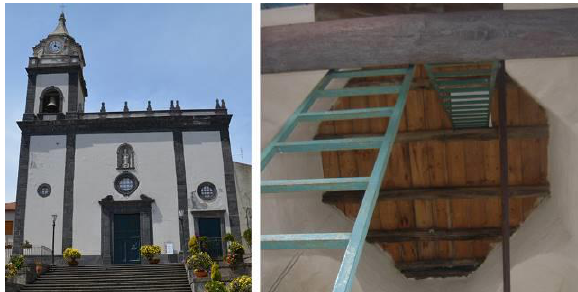
Figure 2. The bell tower of Sant’Antonio Abate in Pedara (Ct). On the right, the floor under the